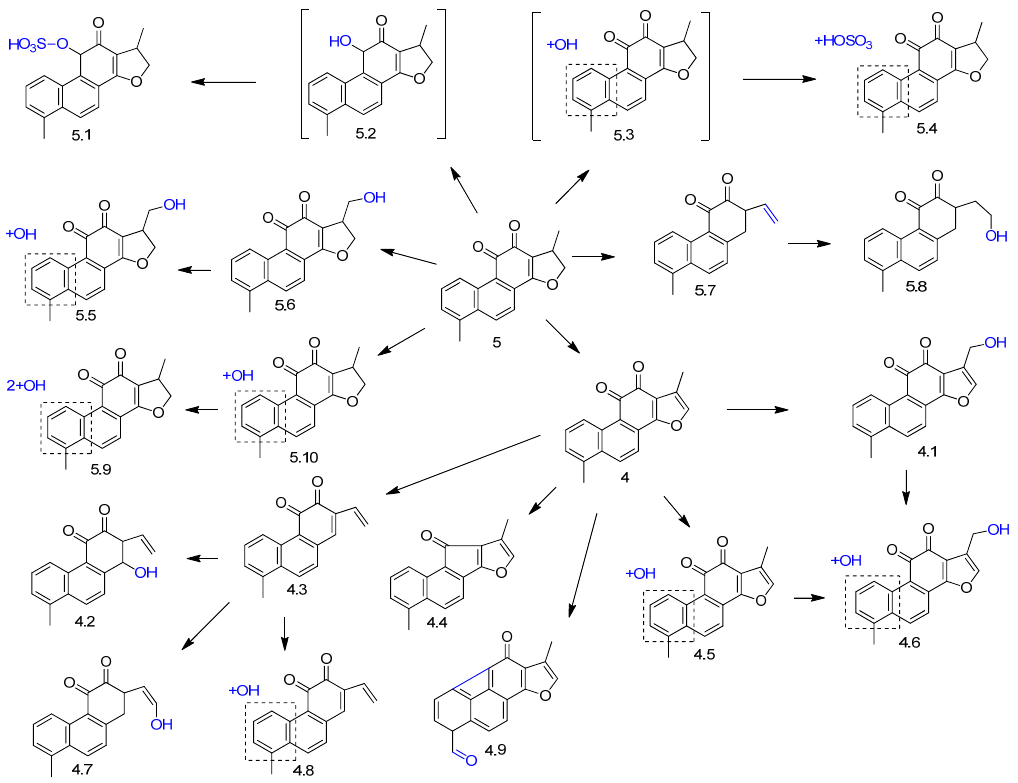
Figure 6. Proposed phase I and phase II metabolites from rat bile biotransformation of tanshinone I ( 4 ) and dihydrotanshinone I ( 5 ) [45].